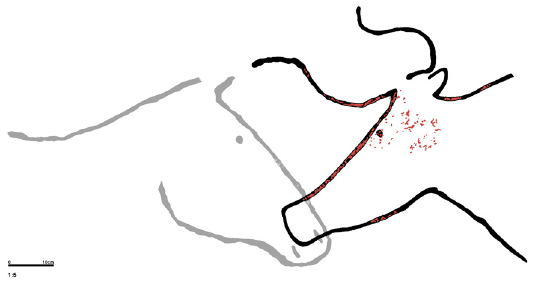
Figure 1. Faia Rock 6, Côa Valley, Portugal. Entangled horse and aurochs depiction strongly suggesting the association of those two symbols. Tracing: Fernando Barbosa, assisted by João Félix, Manuel Almeida and Marcos